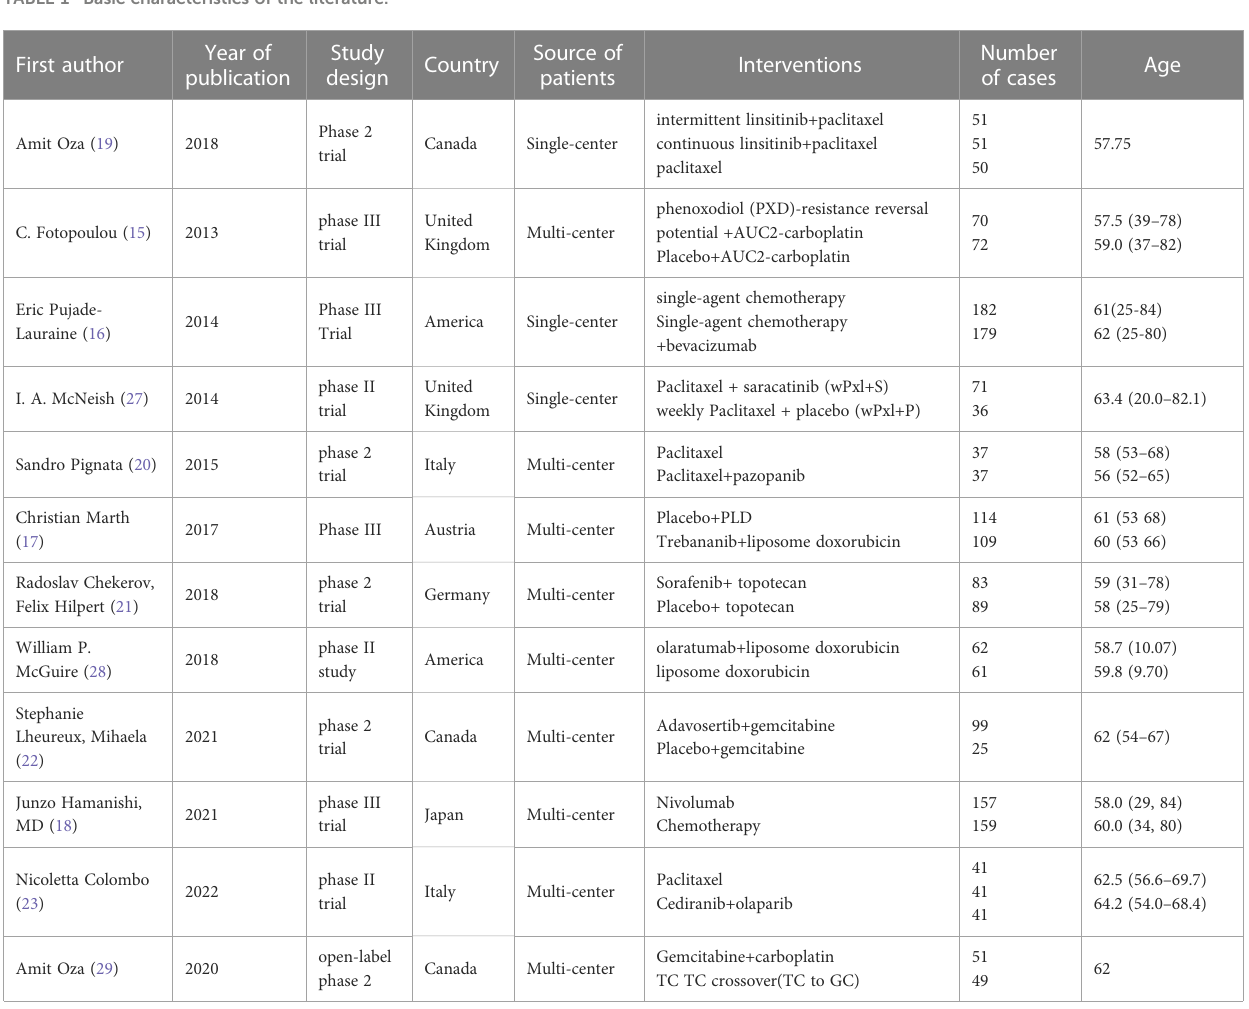
TABLE 1 Basic characteristics of the